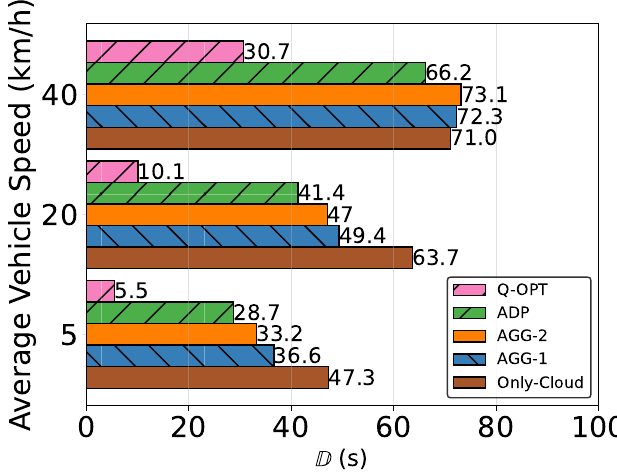
Figure 10. Impact of average vehicle speed on the objective function D